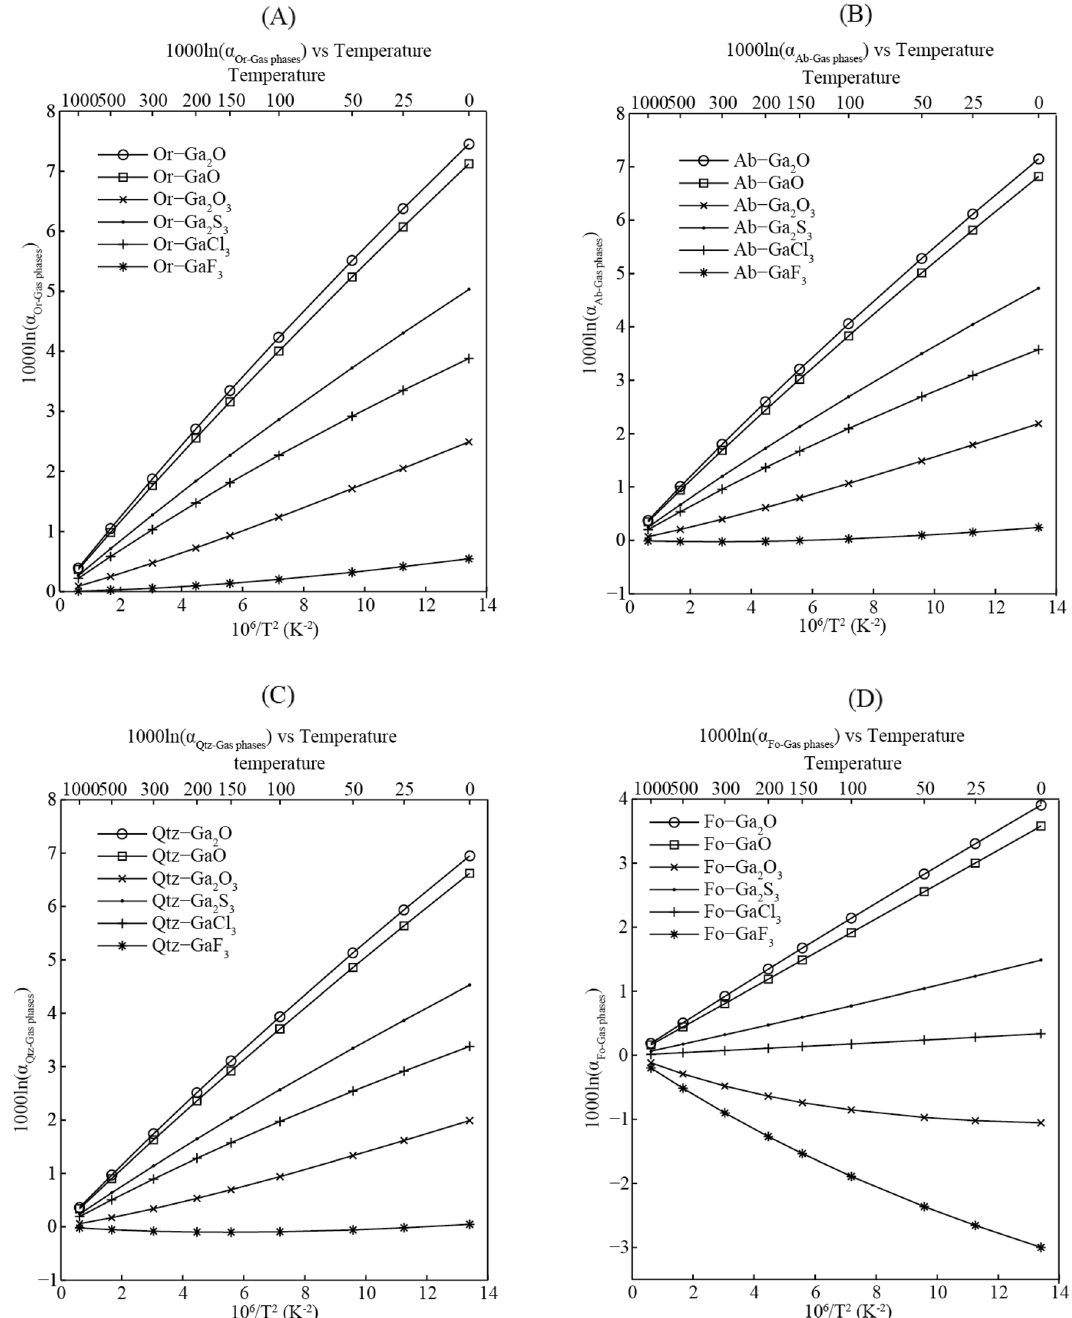
Figure 9. The equilibrium Ga isotope fractionation factors between Ga-bearing minerals ( A ): orthoclase, ( B ): albite, ( C ): quartz and ( D ): forsterite) and gas phases as a function of temperature. Or, Ab, Qtz and Fo are short for orthoclase, albite, quartz and forsterite,